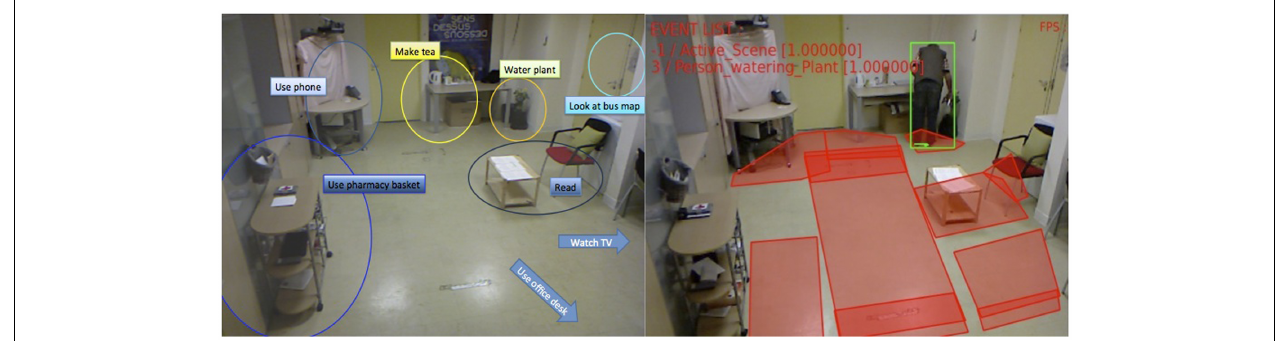
FIGURE 3 | Event recognition based on activity zones. The left image presents the contextual zones used to describe the scene semantics. The right image presents an example of output of the automatic video monitoring system.